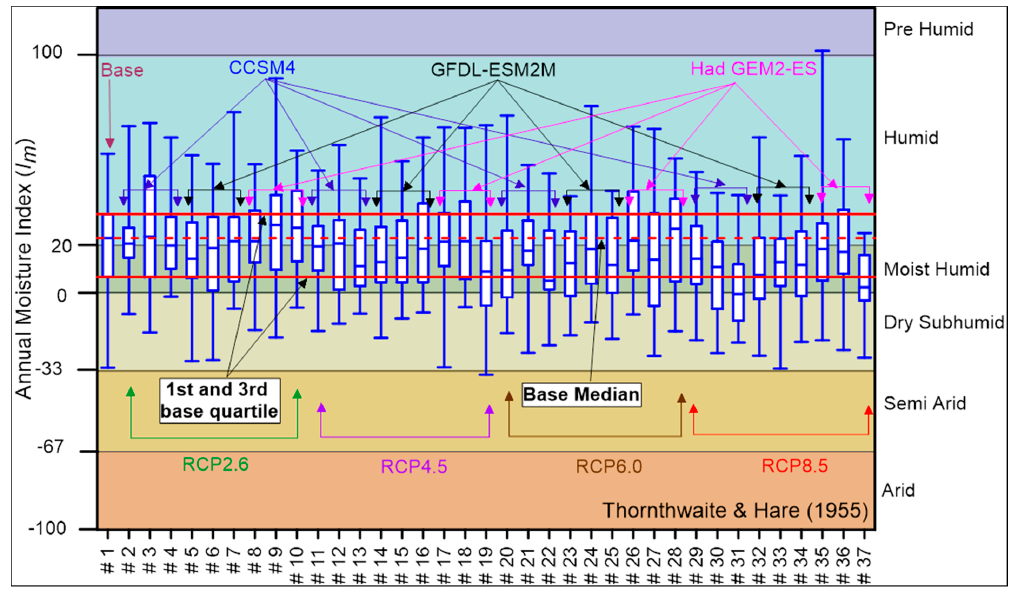
Figure 4. Comparison of annual moisture indices for base and future climate ensembles.